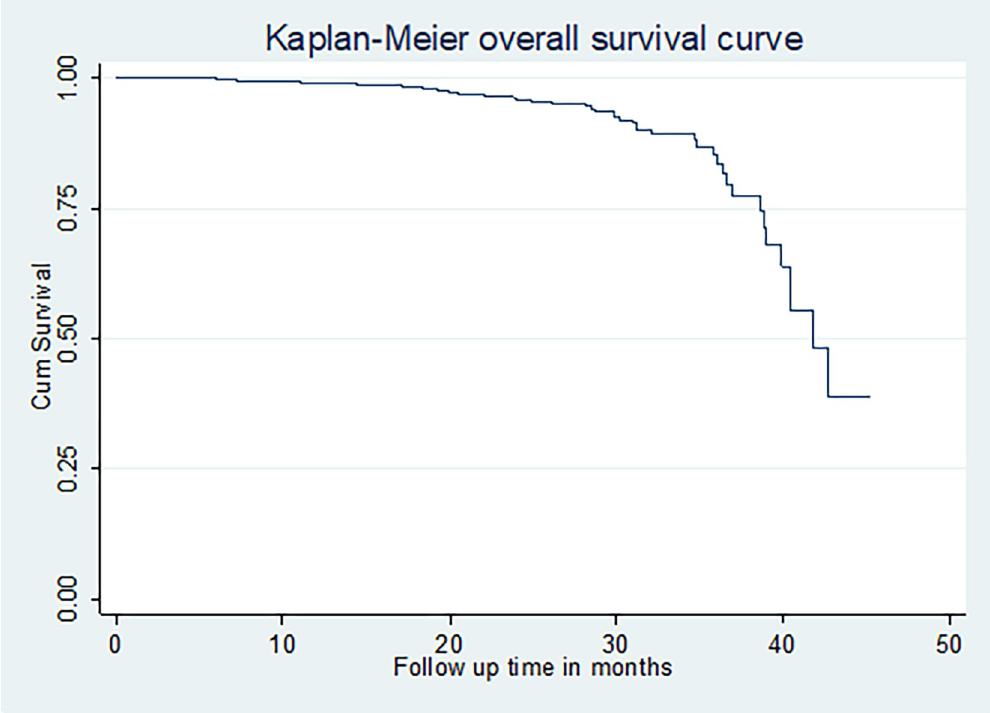
Fig 6. Overall Kaplan-Meier estimation of the overall survival of cervical cancer patients at Felege Hiwot Comprehensive Specialized Hospital Oncology Center, Ethiopia (n = 422, March 2021).